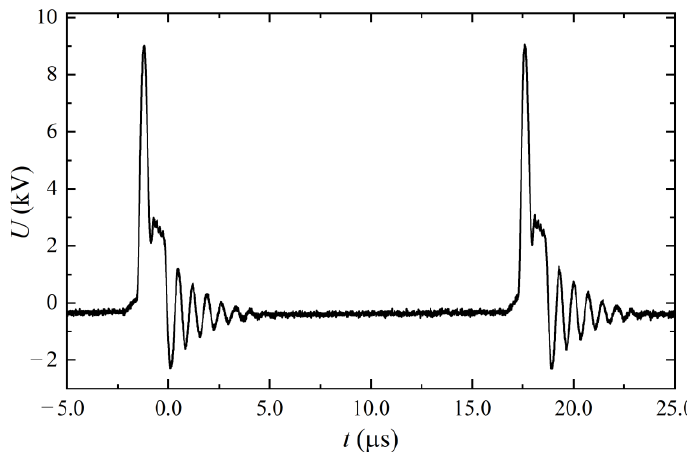
Figure 2. Waveform of the voltage at the HV electrode in the case of the bubble discharge.